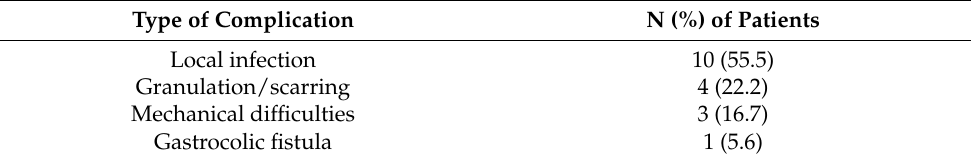
Table 2. Type and frequency of complications after PEG insertion.